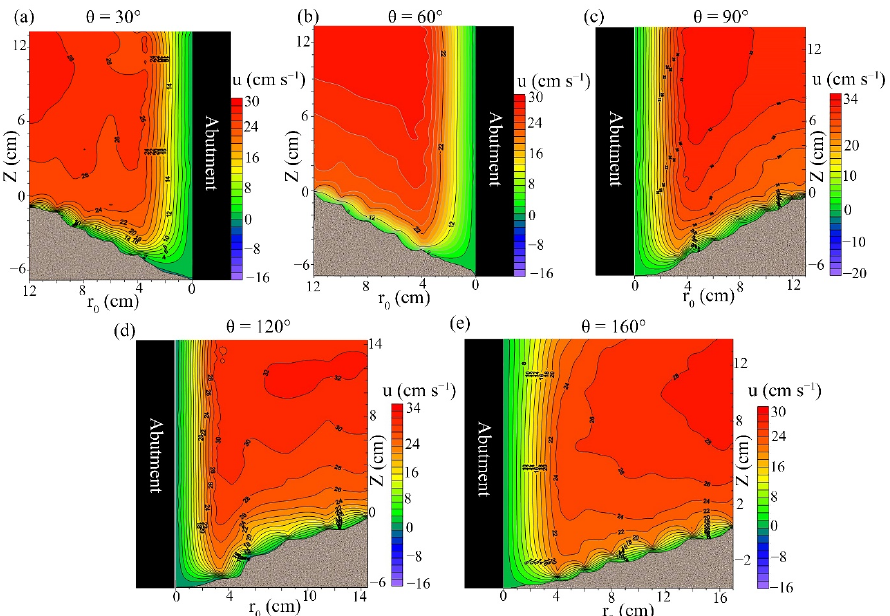
Figure 6. Velocity field for the case bed without vegetation in the tangential direction ( u , cm/s) for different azimuthal sections. Note that the range of the color scale is not equalized for better illus- tratio